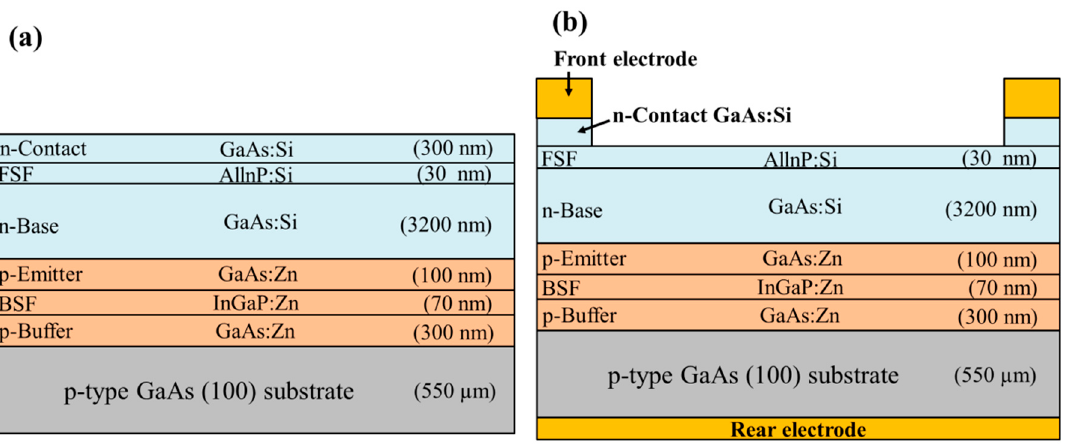
Figure 1. Schematic diagrams of ( a ) epitaxial layers in GaAs single-junction solar cell and ( b ) bare-type GaAs single-junction solar cell.